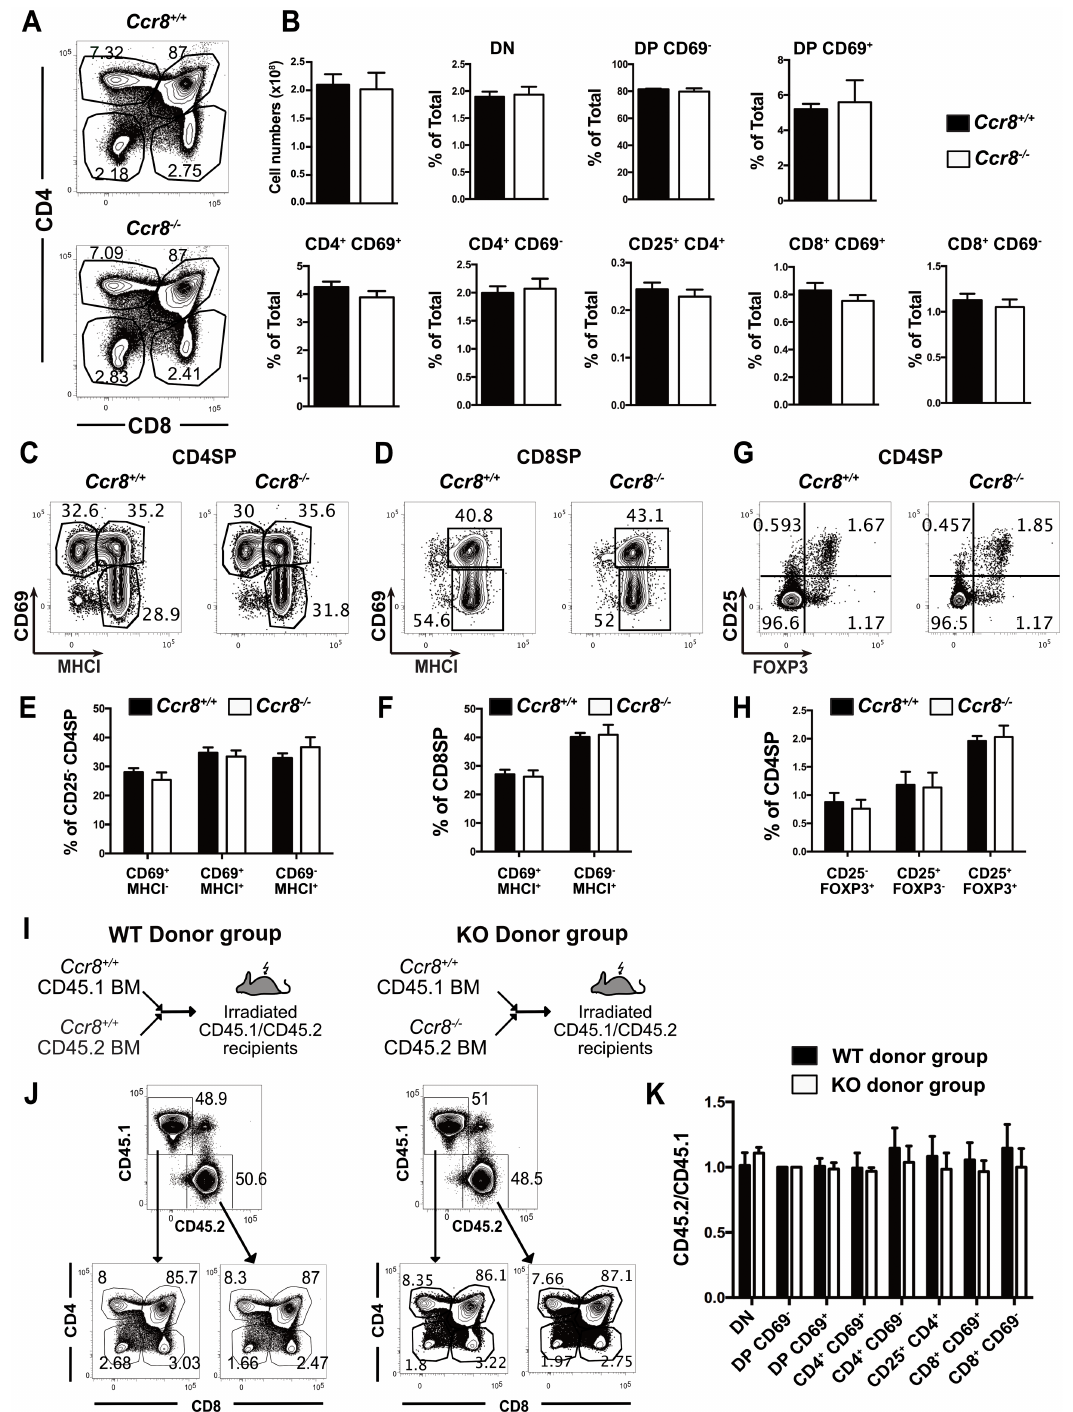
Fig 3. CCR8 is not required for negative selection of polyclonal thymocytes. (A) Representative flow cytometric profiles of CD4 versus CD8 expression on thymocytes from Ccr8 +/+ and Ccr8 -/- mice. (B) Total thymocyte cellularity was quantified, and the percentages of thymocyte subsets in Ccr8 +/+ and Ccr8 -/- mice were calculated from flow cytometric data, as in (A). Graphs show means + SEM compiled from four independent experiments with a total of 12 Ccr8 +/+ and 11 Ccr8 -/- mice. (C-D) Representative flow cytometric profiles of CD69 versus MHCI expression on gated CD4SP (C) and CD8SP (D) thymocytes from Ccr8 +/+ and Ccr8 -/- mice. (E-F) The percentage of each indicated maturation stage within CD25 - CD4SP (E) or CD8SP (F) subsets were quantified